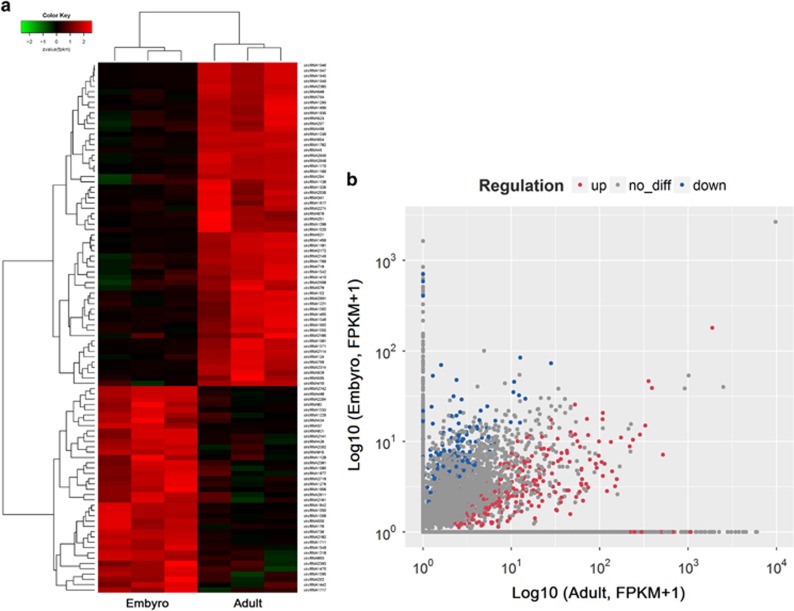
Differentially expressed circular RNAs in bovine skeletal muscle. (a) Clustered heat map of the top 100 most differentially expressed circRNAs when comparing embryonic and adult muscle tissues, and (b) scatter plot showing the correlation between abundances of individual circRNAs at the embryonic and adult stage